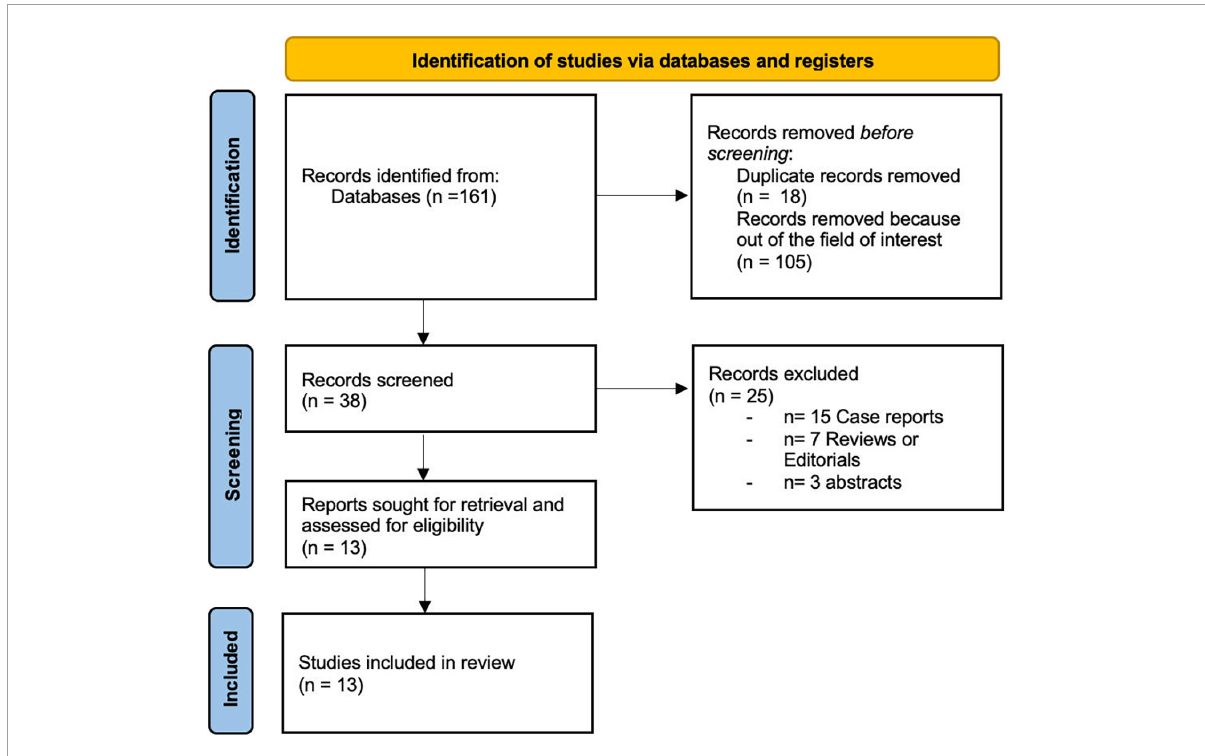
FIGURE1 Review flow